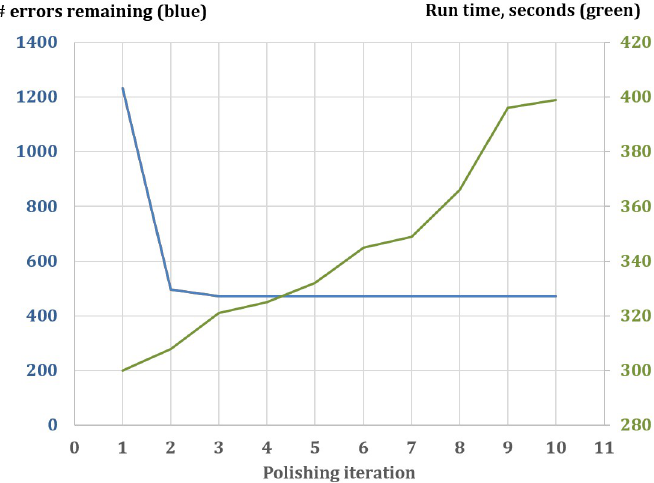
Fig 3. Number of errors remaining after polishing (green, left axis) and the run time of JASPER (green, right axis) for different number of polishing iterations (-p parameter), on A . thaliana data with simulated errors with K = 63. The number of errors stops decreasing after three iterations, and it never increases for up to 10 iterations. The run time increases approximately linearly with the number of iterations. We do not show the original number of errors (pass 0), because it is large